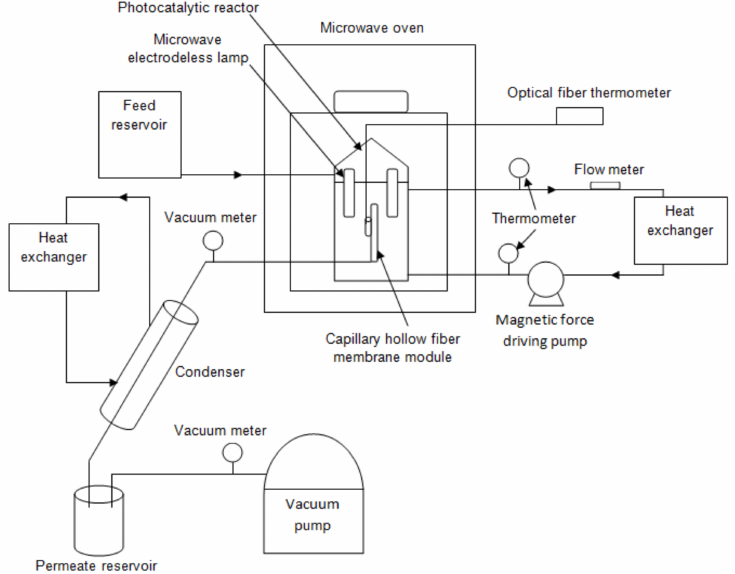
Figure 14. Schematic diagram of PMR utilizing microwave assisted photocatalysis and vacuum membrane distillation for wastewater treatment